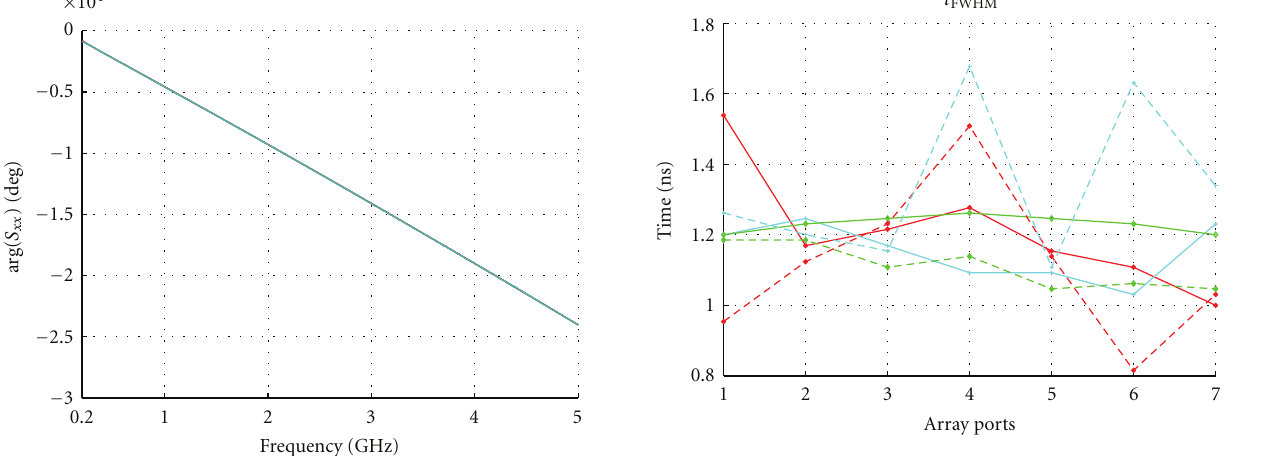
Figure 8: Phase of transmission. Input at B5. Output at A1, A3, A5, and A7.